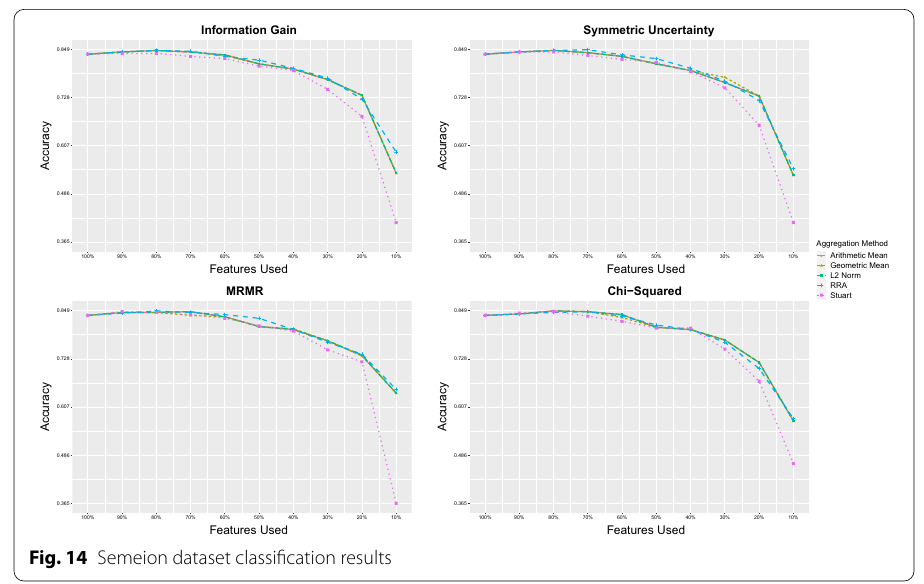
Stability of the Ensemble Feature Selection (Information Gain) by Aggregation Technique Used